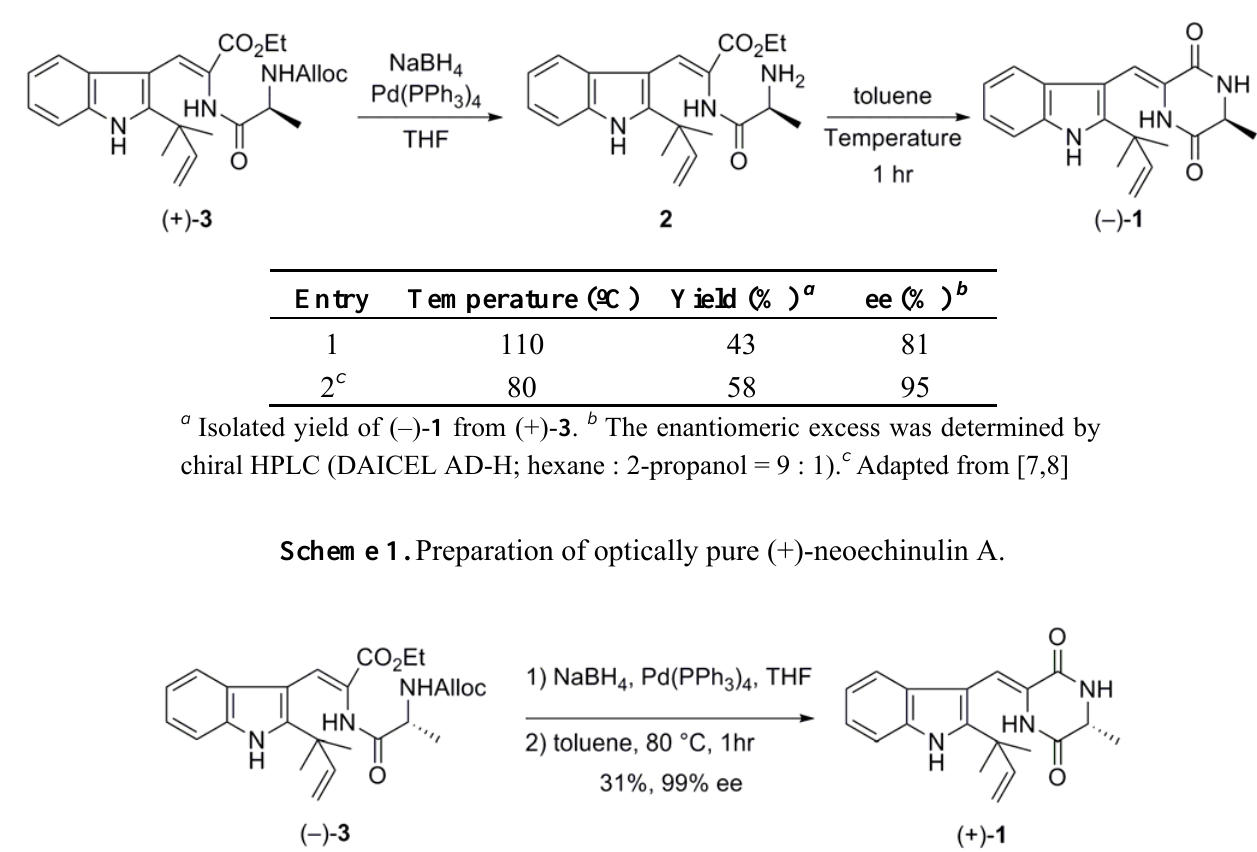
Table 1. Preparation of optically pure (–)-neoechinulin A.